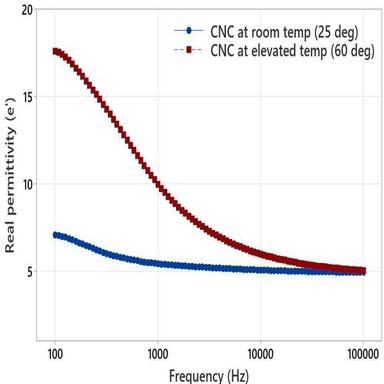
Real permittivity of CNC at room (25 ℃) and elevated (60 ℃) temperatures.